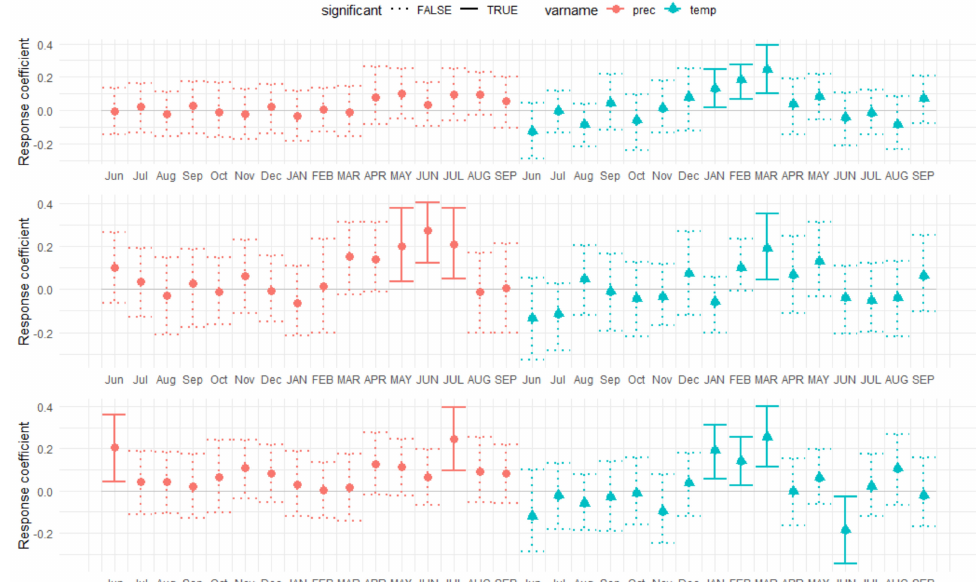
Figure 6. Plot of bootstrapped response function analysis relating tree ring growth in Scots pine ( Pinus sylvestris ) (upper), Norway spruce ( Picea abies ) (Centre), and Douglas fir ( Pseudotsuga menziesii ) (lower) to sums of precipitation and mean monthly temperature from previous June to current Septem- ber, Scharbeutz (northern Germany). Abbreviated previous-year months are given in lowercase letters, and current year months are given in uppercase letters.